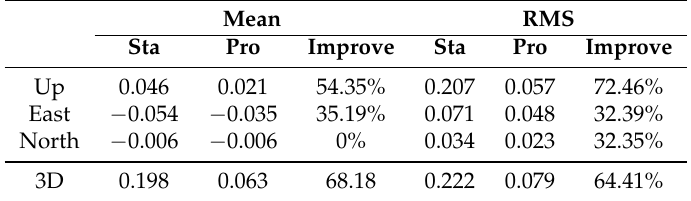
Table 4. Statistics of the mean and RMS residuals for PPP with and without DIA during Event 1. The unit is m . Mean RMS Sta Pro Improve Sta